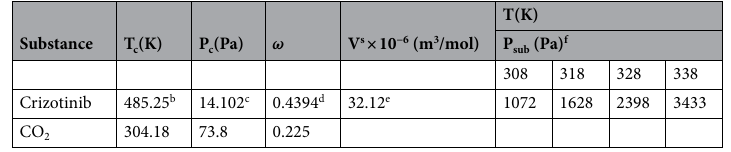
Table 6. Critical and physical properties of Crizotinibinand CO 2a . a T c :critical temperature; P c :critical pressure; ω :acentric factor; V s :solid molar volume; T:Temperature. b Estimated by Fedors method. c Estimated by Joback and Reed method. d Estimated by Lee-Keslervapour pressure relations (Note: the required normal boiling temperature (at 1.0 atm), T b is estimated with Klincewicz relation, T c = 50.2 − 0.16 M + 1.41 T b , where M is molecular weight). e Estimated by Immirzi, A., Perini, B method. f Estimated by Lee-Kesler vapour method.